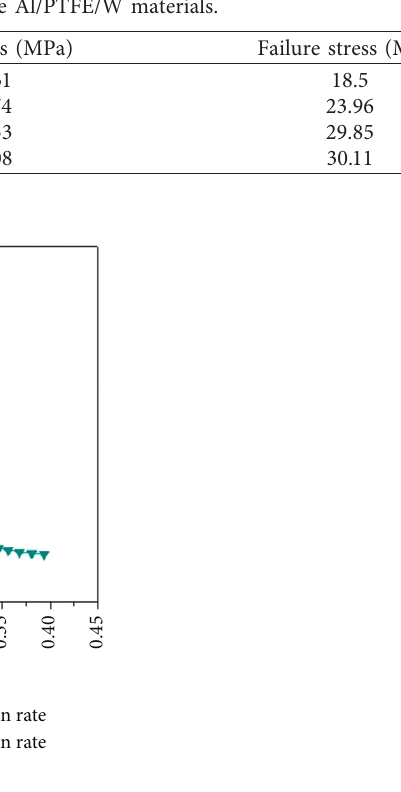
Figure 12: Stress-strain curves of Al/PTFE/W energetic materials at different strain rates with the same ratio (the W content was 45%).